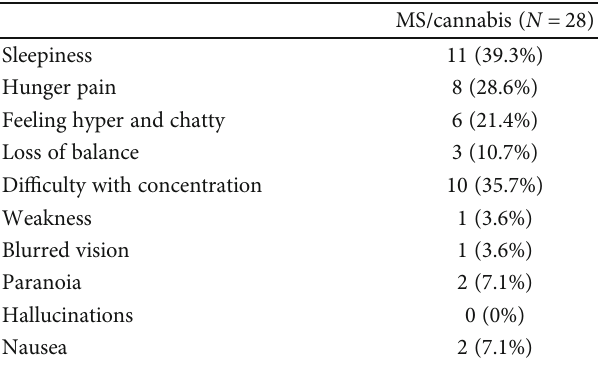
Table 5: Side e ff ects in the MS cases (chronic cannabis